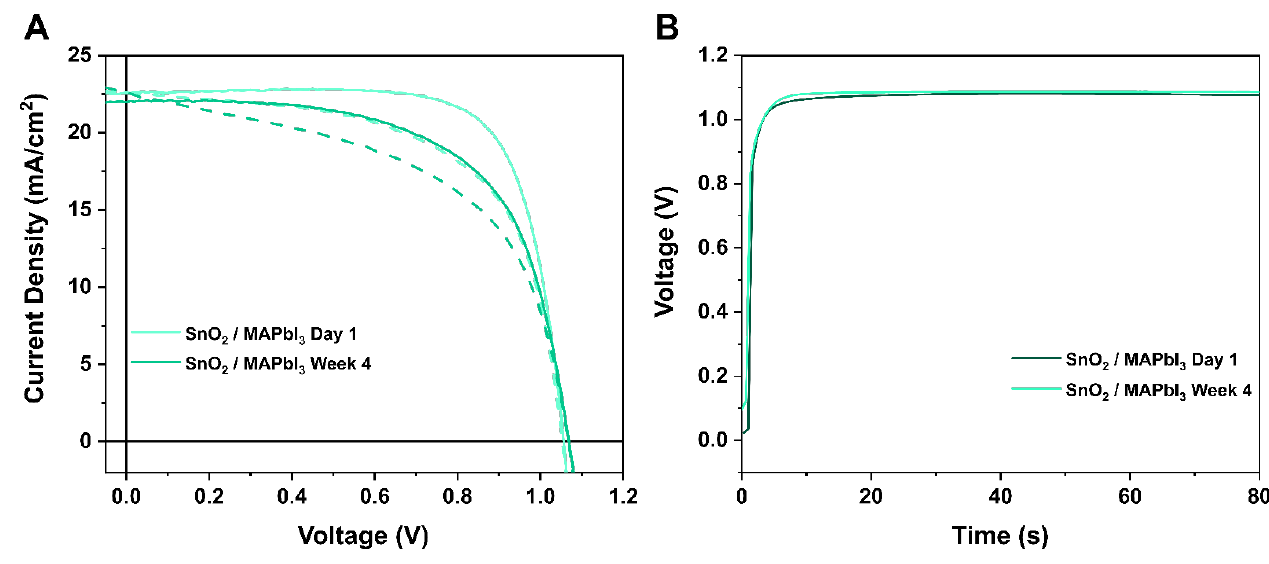
Figure 5. JV curves measured at 1 Sun conditions (100 mW/cm 2 , AM 1.5G) in forward (dashed line) and reverse (solid line) scan for fresh and aged samples of MAPbI 3 deposited on SnO 2 ( A ) and V OC stability over a period of time for fresh and aged MAPbI 3 samples ( B ). Table 2. Summary of the photovoltaic parameters for MAPbI 3 on SnO 2 measured in fresh (1 day) and aged (28 days) conditions.